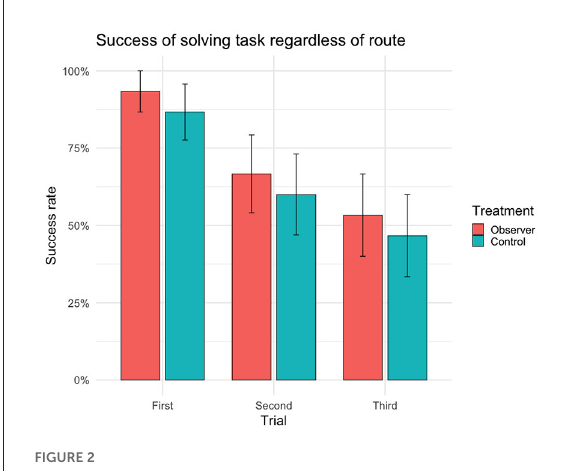
FIGURE2 Success rate (sample mean) of reaching the yellow reward bucket and solving task within 90 s regardless of route (i.e. achieving complete or partial success) for each trial ( n = 30 cows, 90 trials). Error bars indicating SEM.